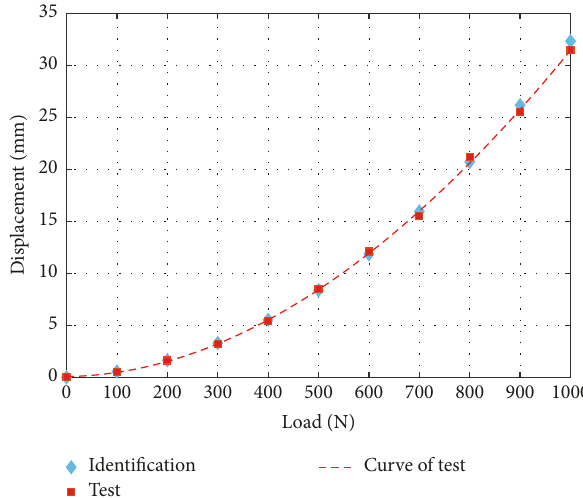
Figure 8: Results comparison of identification and